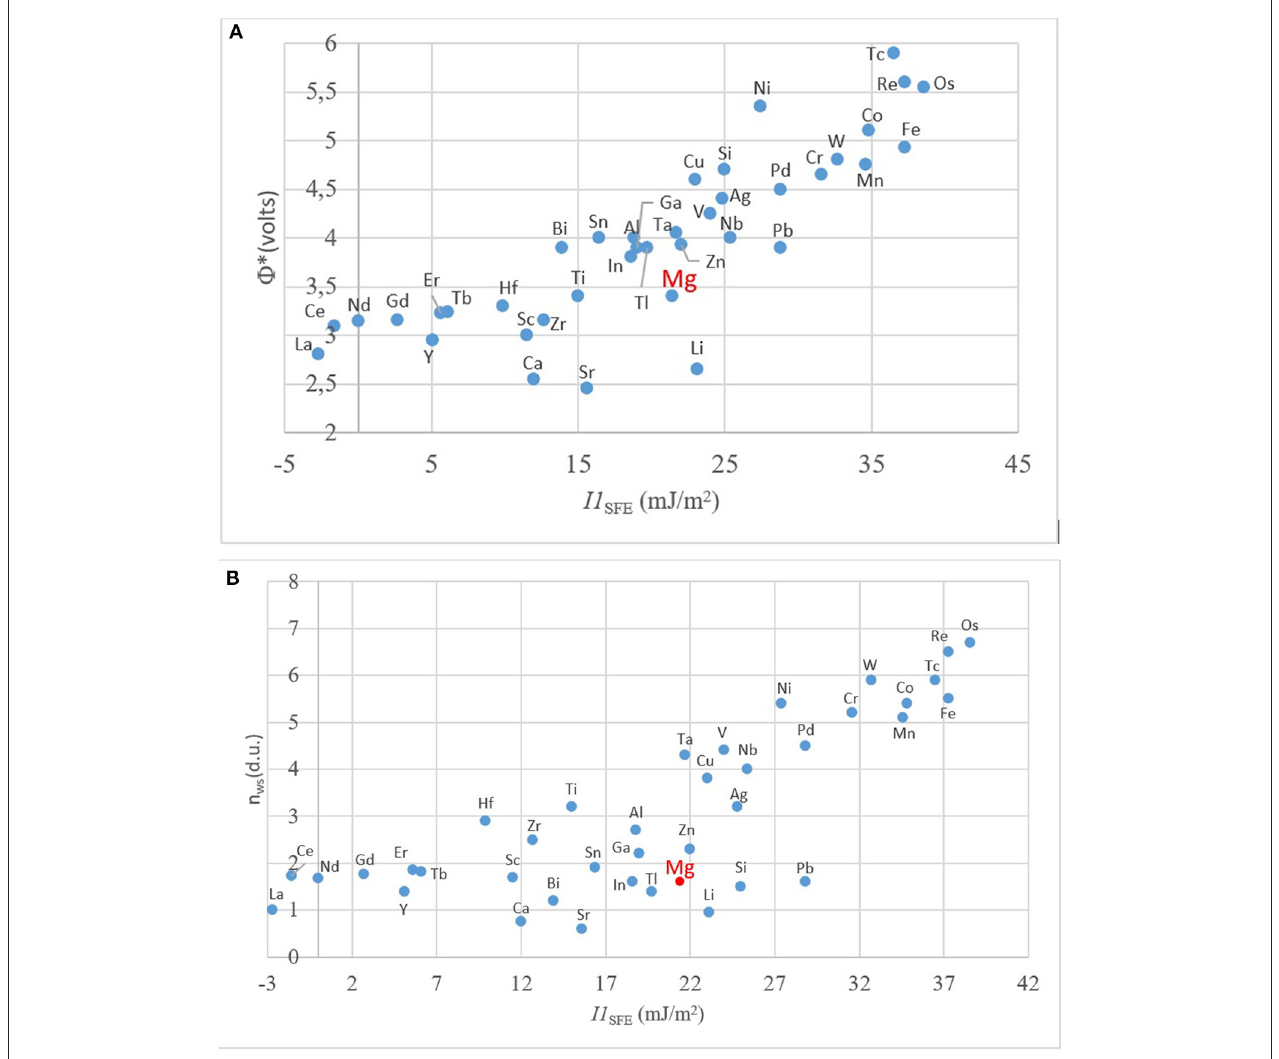
FIGURE 7 | The relationship between the computed values of I1 SFE with (A) Φ *; and (B) n WS . ( Φ * and n WS values are from Miedema, 1973a,b; Abaspour and Cáceres, 2015 ; SFE values from Wang T. et al., 2014 and Dong et al.,